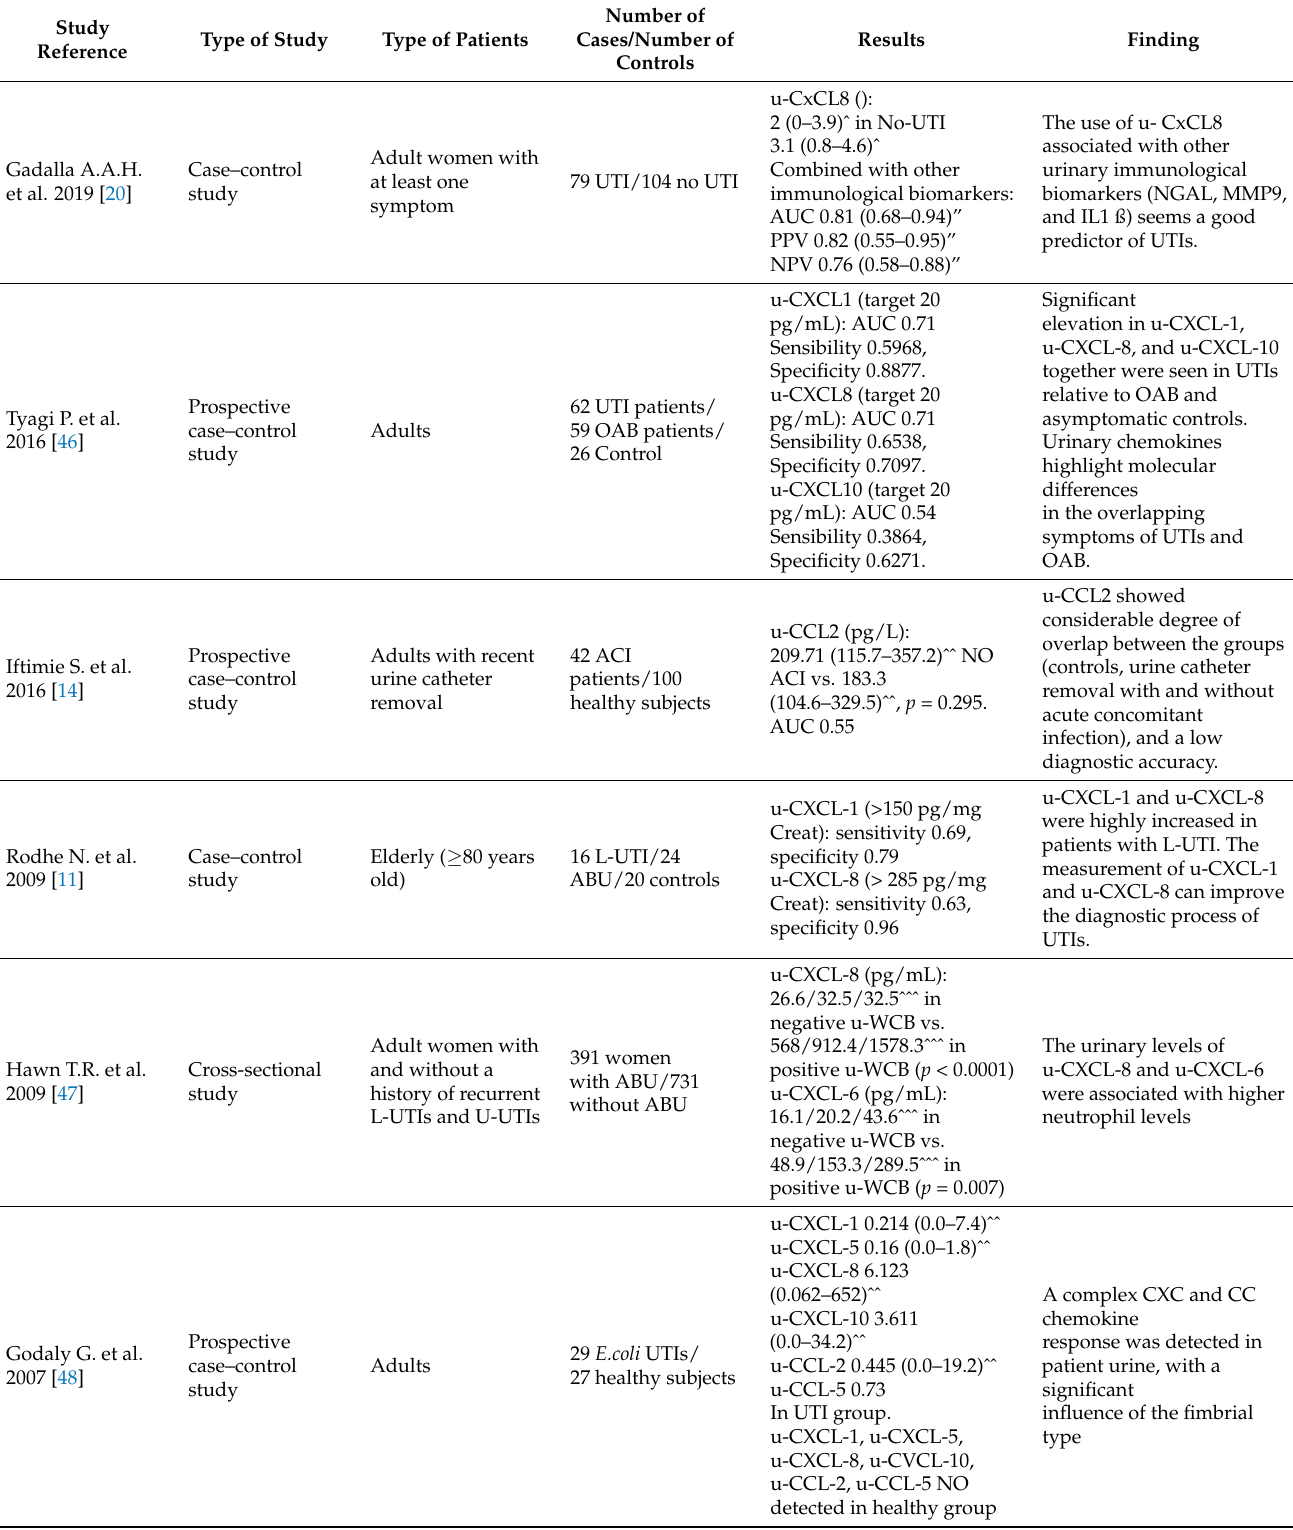
Table 6. Serum and urine chemokines diagnostic value in UTIs; target population: